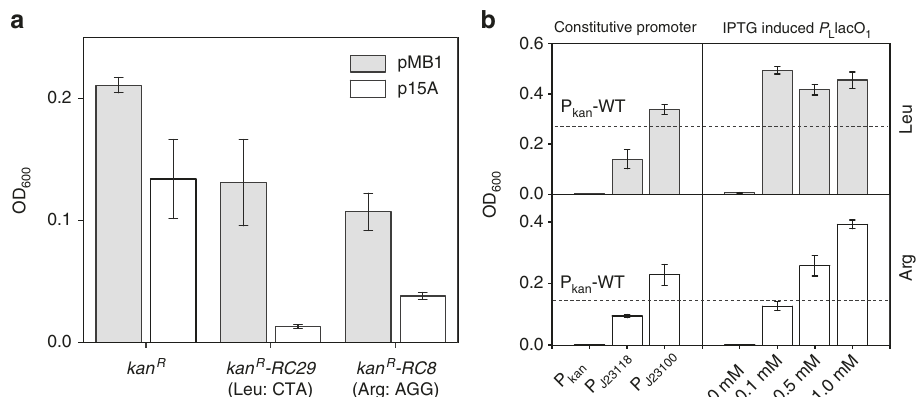
Fig. 4 Selection stringency mediated by copy number and promoter strength. The kan R , kan R -RC29 , and kan R -RC8 represent the wild-type kan R , the kan R containing leucine rare codon CTA, and the kan R containing arginine rare codon AGG, respectively. a The effects of different ORIs on the cell OD 600 for strains harboring the wild-type and the rare codon-rich markers. b The effects of constitutive and inducible promoters on the cell OD 600 for strains harboring the rare codon-rich markers, the dashed line represents the cell OD 600 for strain carrying the wild-type kan R driven by its original promoter from pET-28a. Values and error bars represent the mean and the s.d. ( n =